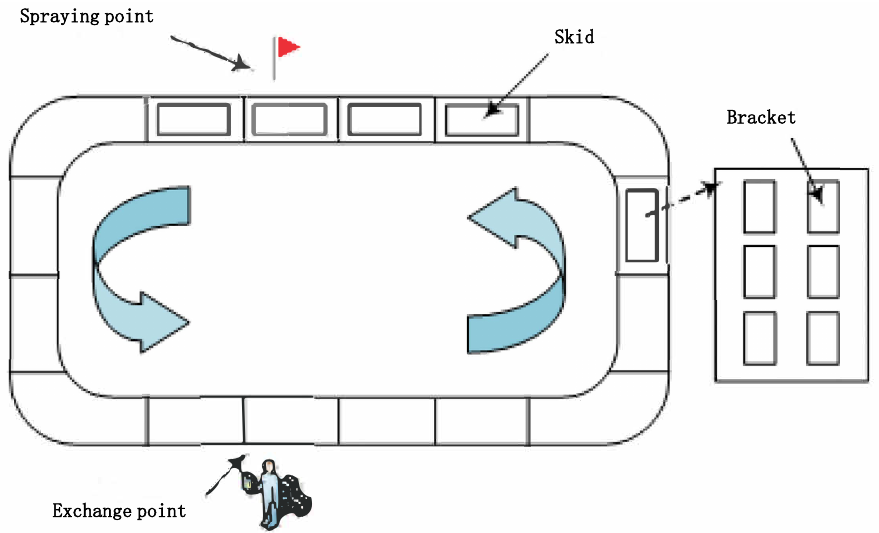
Figure 1. Schematic diagram of spraying process.